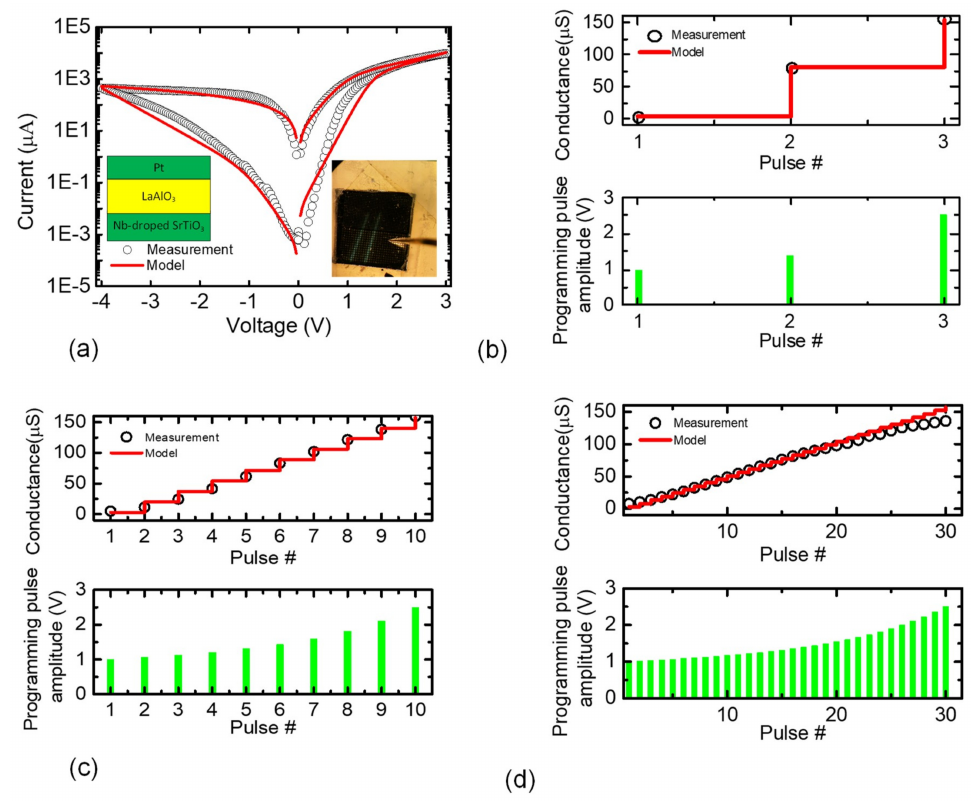
Figure 3. ( a ) The measured and calculated current-voltage relationships of the fabricated memristor, the cross-sectional view of the measured device, and the microscope picture of the measured device. ( b ) The coarse programming scheme and the memristor’s conductance changes. ( c ) The moderate programming scheme with the memristor’s conductance changes. ( d ) The fine programming